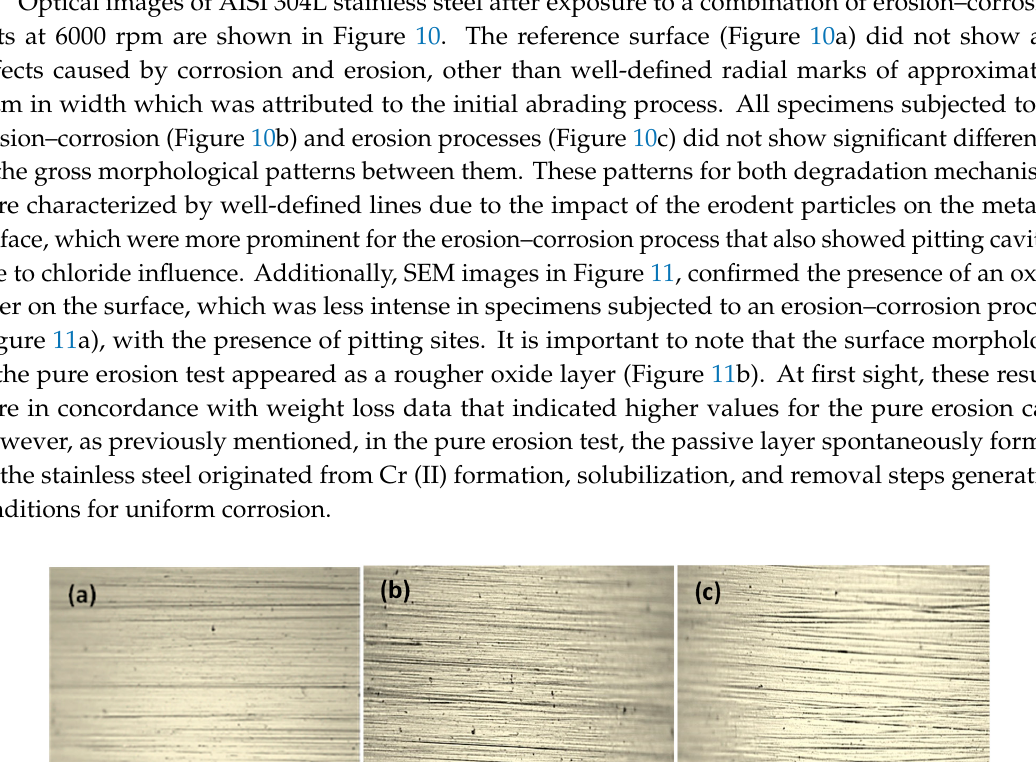
Figure 9. Synergy effect ( S E-C ) for AISI 304L stainless steel determined by using Equation (1).